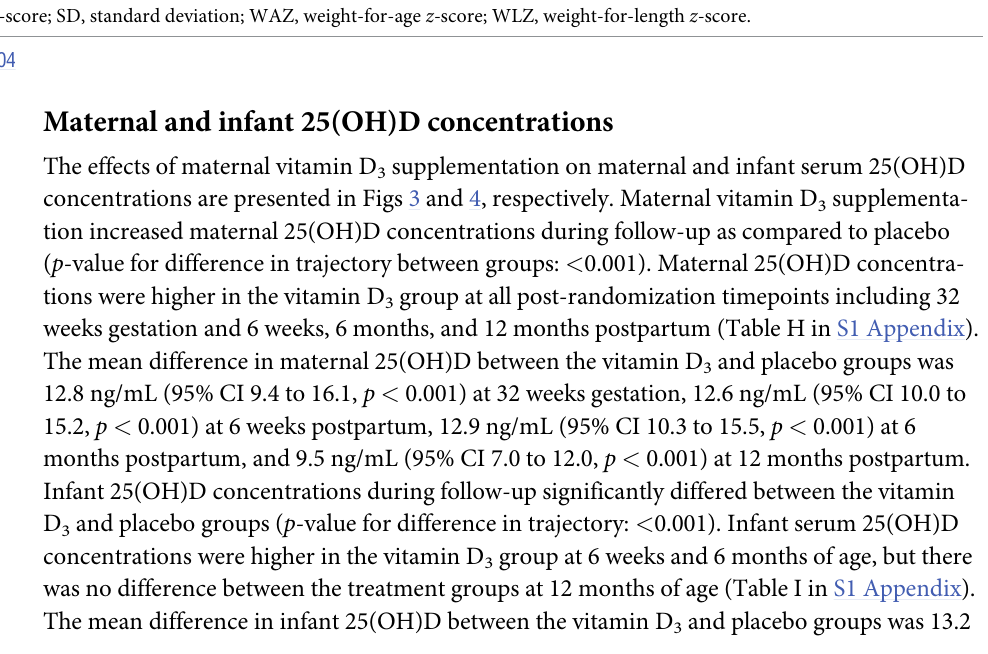
Infant 25(OH)D concentrations during follow-up significantly differed between the vitamin D and placebo groups ( p -value for difference in trajectory: < 0.001). Infant serum 25(OH)D 3 concentrations were higher in the vitamin D group at 6 weeks and 6 months of age, but there 3 was no difference between the treatment groups at 12 months of age (Table I in S1 Appendix). The mean difference in infant 25(OH)D between the vitamin D and placebo groups was 13.2 3